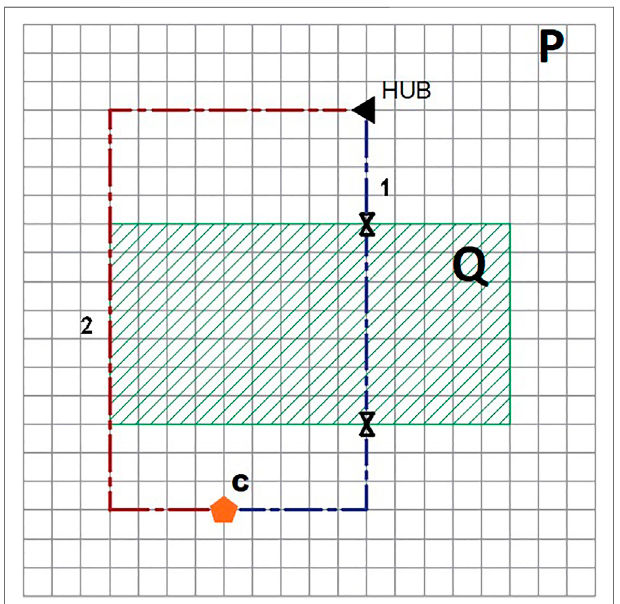
FIGURE 3 | Case 3: Customer c located opposite of high-intensity zone Q